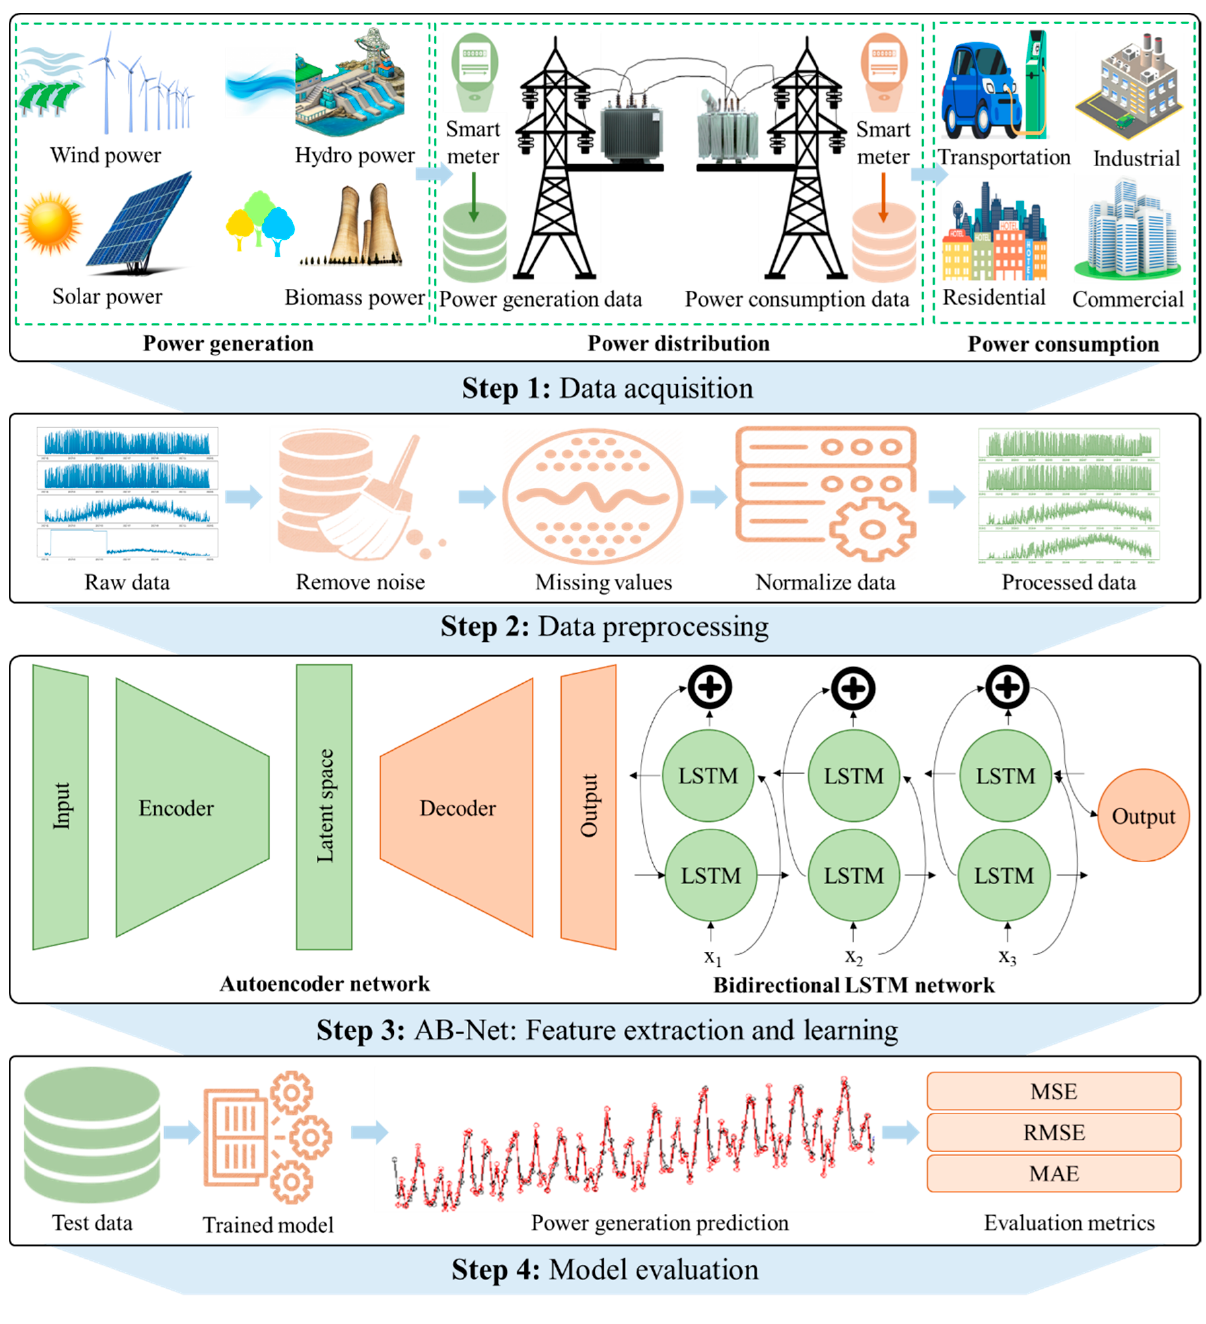
Figure 1. Overall framework of the proposed architecture. In step 1, the power generation data are acquired, which are further preprocessed in step 2. In step 3, the features are extracted and passed through the BiLSTM for decoding. In step 4, the predictions are obtained based on the trained model that is evaluated through basic error metrics and graphs.